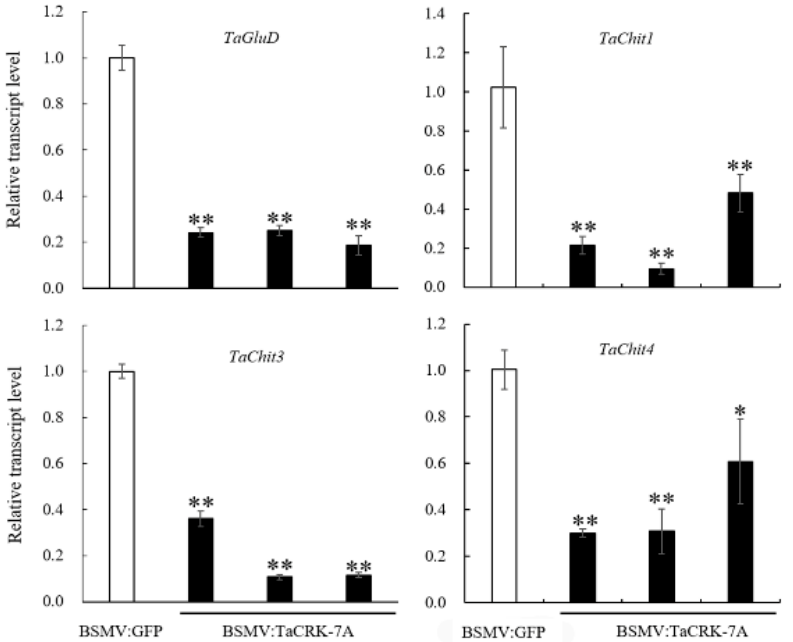
Figure 4. Silencing of TaCRK-7A reduced transcript abundances of defense genes in wheat CI12633 plants at 7 dpi with F. pseudograminearum WHF220. Relative transcript abundances of these defense genes in BSMV:TaCRK-7A-silenced CI12633 plants were quantified relative to those in BSMV:GFP-infected control plants. TaActin was used as internal control. Statistically significant differences were determined based on three replications using Student’s t ‐ test (** p < 0.01).